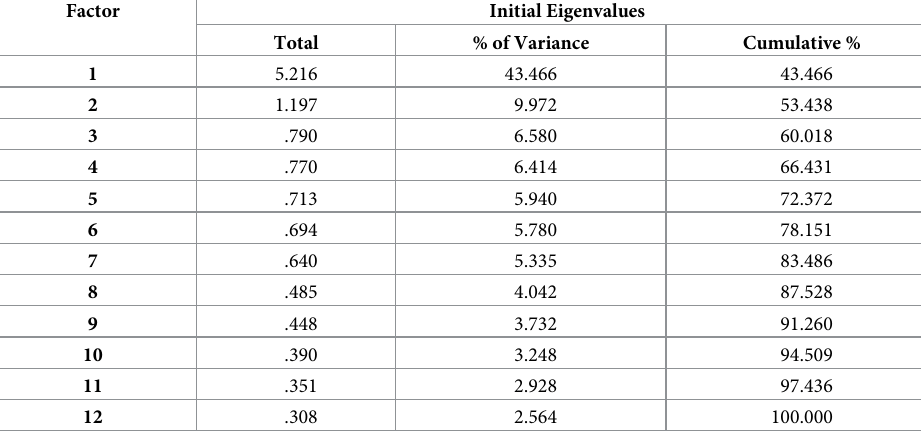
Table 3. Principal axis factoring—Total variance